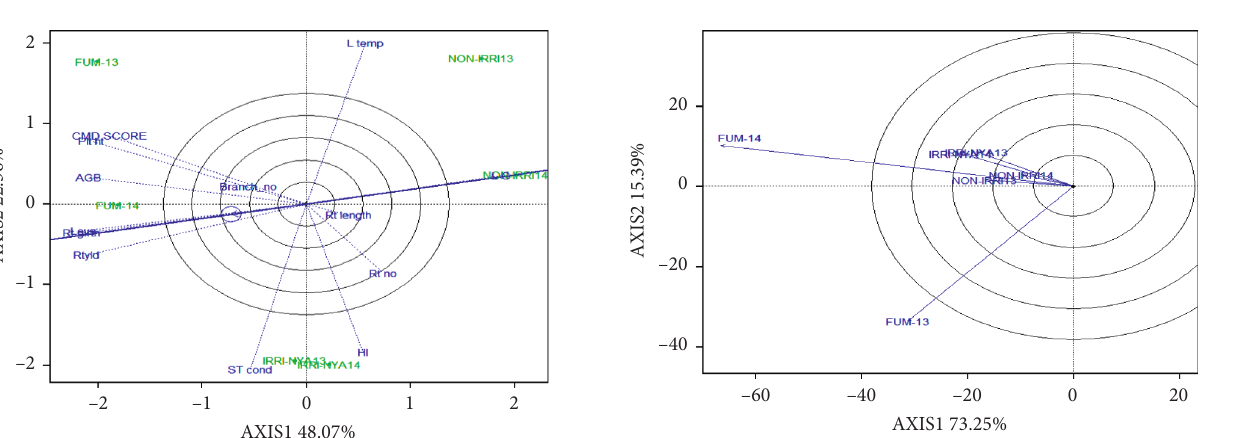
Figure 3: Relationships between traits and different environments. Figure 4: Relationship between environments. FUM- 13 � Fumesua 2013, NON-IRRI13 � no irrigation 2013, IRRI- NYA13 � irrigation 2013, FUM-14 � Fumesua 2014, NON- IRRI14 � no irrigation 2014, and IRRI-NYA14 � irrigation 2014.